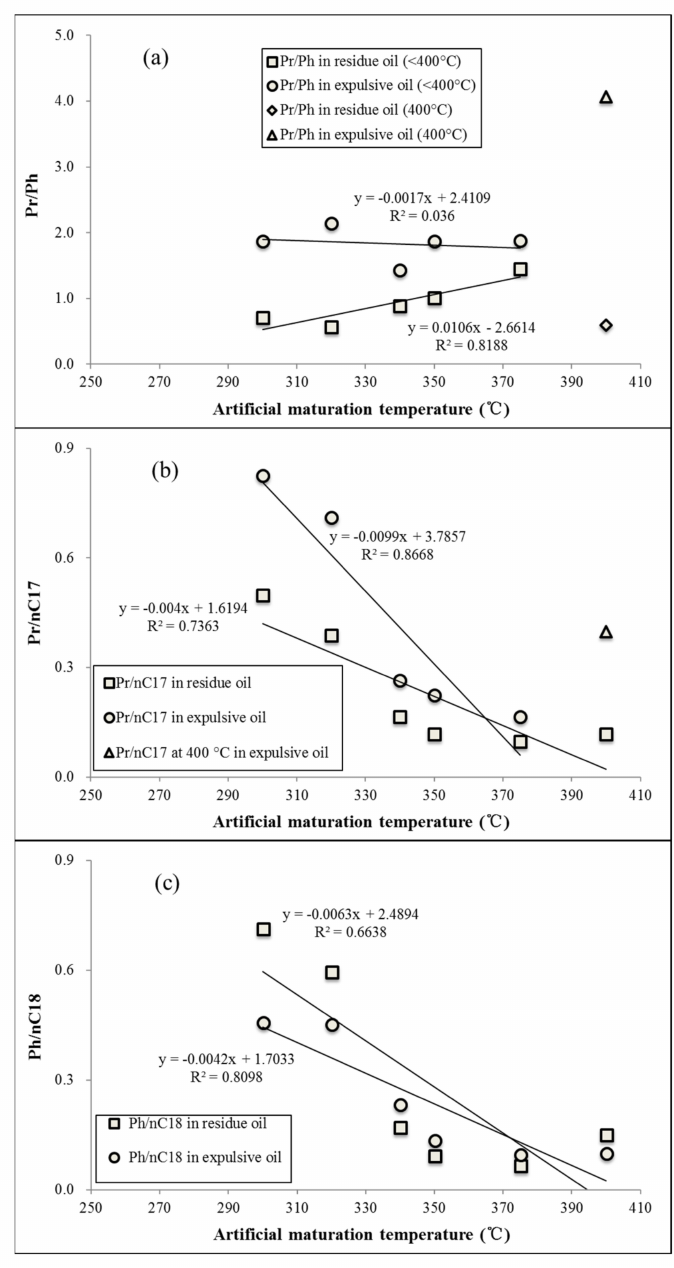
Figure 10. Pr/Ph ( a ), Pr/ n -C17( b ), and Ph/ n -C18 ( c ) vs artificial maturation temperature for residual oil and expelled oil from the Tasmanite oil